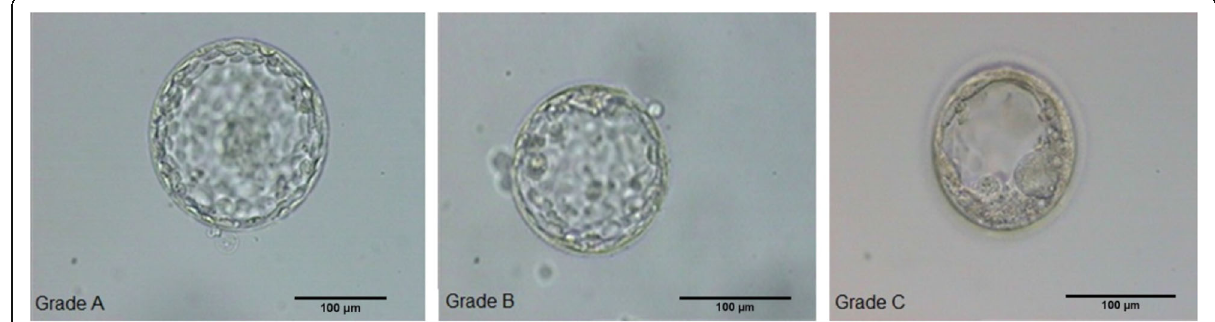
Fig. 2 Micrograph showing the three different morphology grades (A, B, C) (Hardarson 2003) of blastocysts. Grade A, grade A blastocysts were expanded with a distinct inner cell mass (ICM) and many cells organized in the trophectoderm. Grade B, grade B blastocysts were either poorly expanded and/or with less defined ICM and trophectoderm cells but without signs of degenerative foci. Grade C, blastocysts exhibited poor morphology, characterized by a number of degenerative foci in the ICM and trophectoderm and a poorly developed blastocyst